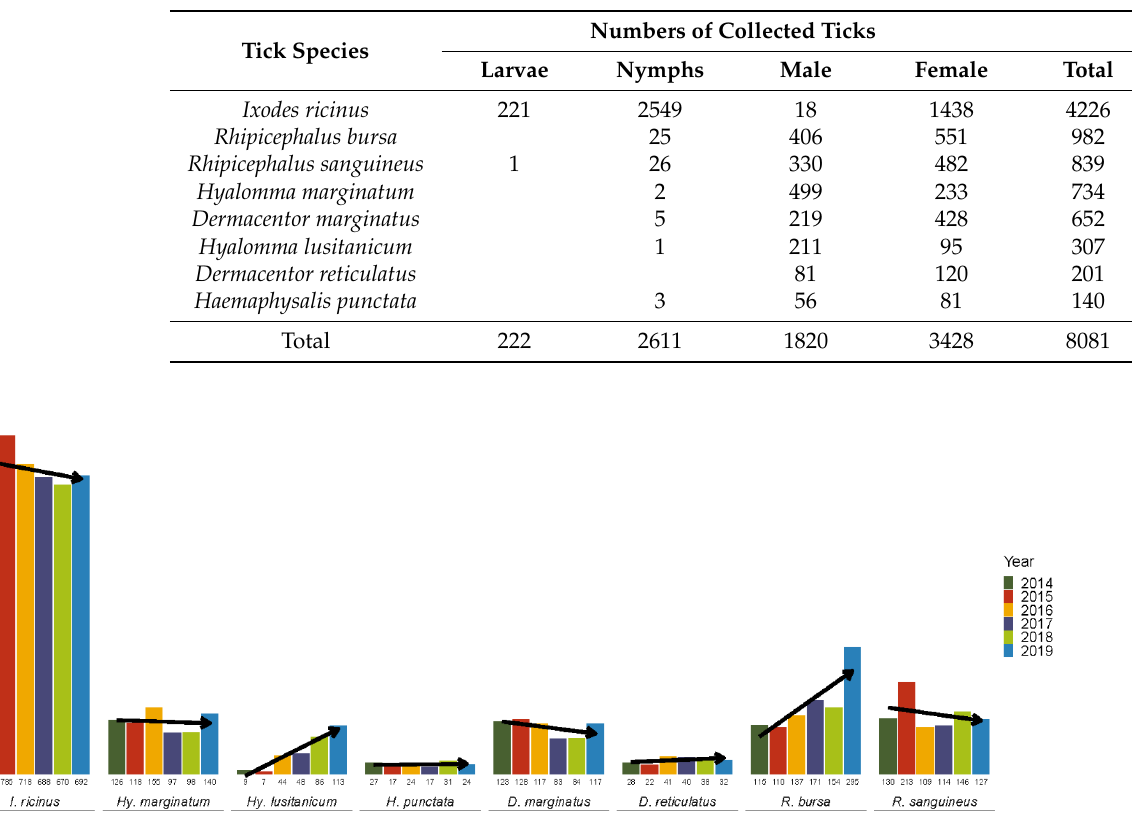
Table 1. Numbers of collected ticks, species, life stages and sex.